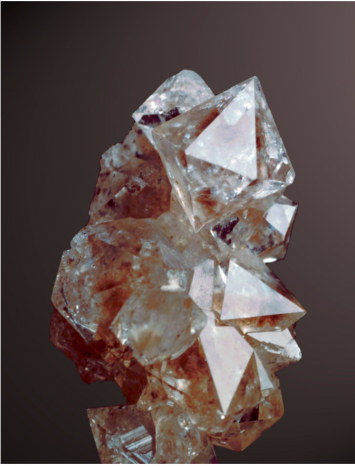
Figure 16. Quartz, Chub Lake prospect. 3 cm. Chamberlain Collection, NYSM 12183. SC.